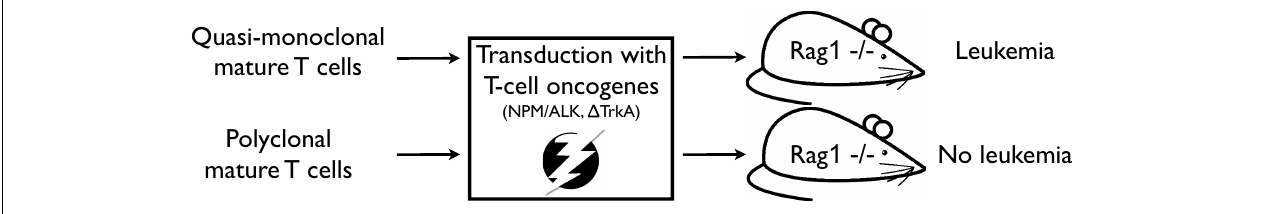
FIGURE 1 | Experimental strategy as described in Newrzela et al. (21) .TCR quasi-monoclonalT-cell populations transduced with potentT-cell oncogenes developed matureT-cell lymphoma/leukemia in RAG1-deficient recipient mice, whileTCR polyclonalT-cell populations that have been subjected to the same transformation assay did